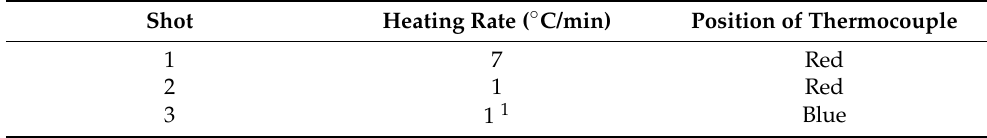
Table 2. Test conditions.